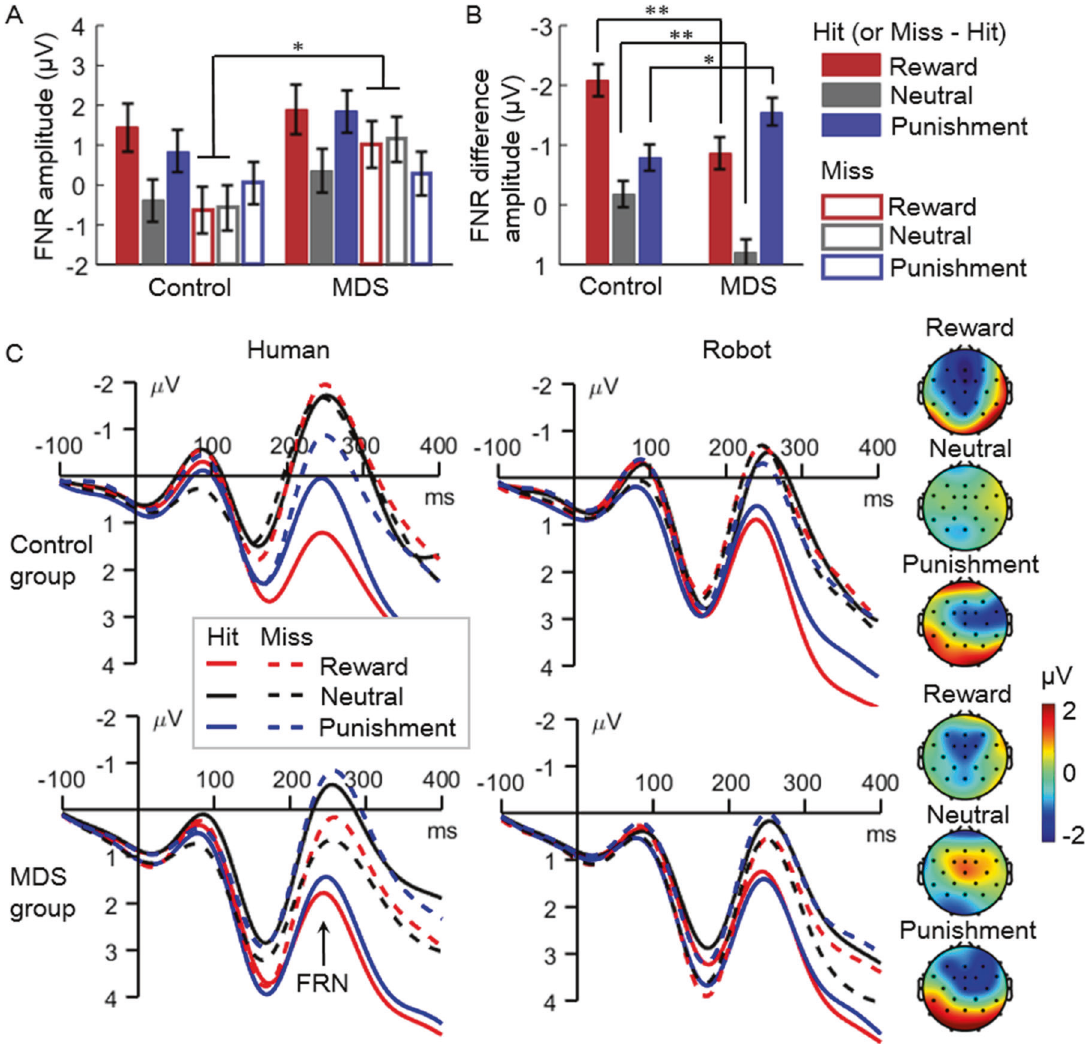
Fig. 3 The results of feedback-related negativity (FRN). A Amplitudes of the FRN in different conditions. B Difference amplitudes of the FRN (miss subtracting hit trials). Error bars indicate two standard errors. * P < 0.05, ** P < 0.01. C The FRN waveforms and topographies. The FRN waveforms were averaged across electrodes of Fz, FCz, FC1, and FC2. The FRN topographies were created according to difference amplitudes (miss subtracting hit trials) averaged across a time window of 200 – 300 post